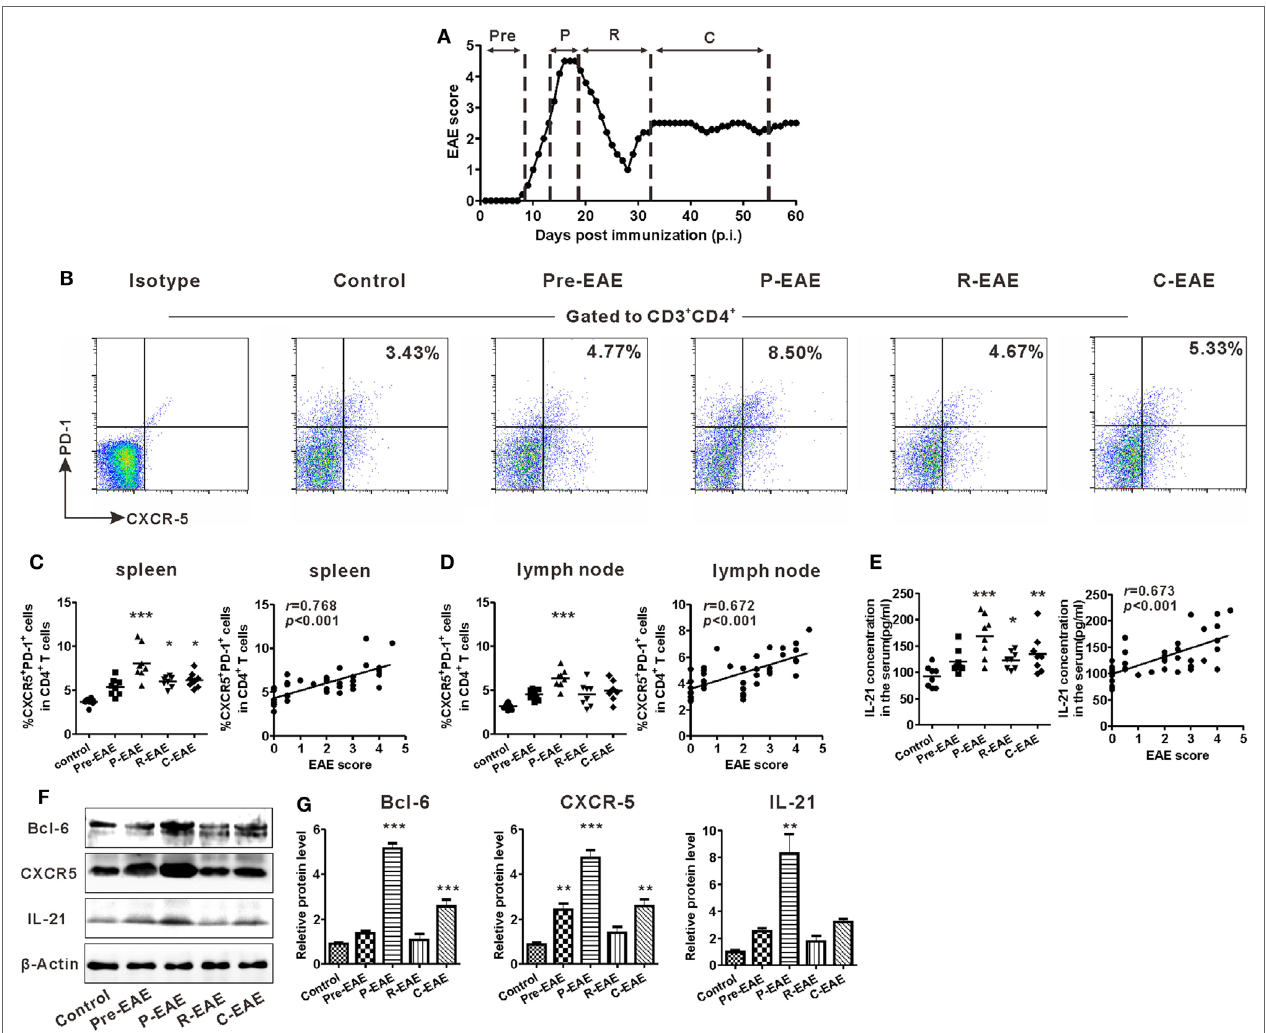
FigUre 2 | Kinetics of T follicular helper (Tfh)-like cell in the secondary lymphoid organs (SLOs) during the different phases of experimental autoimmune encephalomyelitis (EAE). (a) The clinical course of MOG 35–55 -induced EAE in C57BL/6J mice. Mean clinical score is shown ( n = 8). (B) Representative flow cytometry results of CD3 + CD4 + CXCR5 + PD-1 + Tfh-like cells in the spleens of EAE mice during different clinical phases. Gates were set on CD3 + CD4 + cells. Numbers in the upright corner illustrated the percentage of CXCR5 + PD-1 + cells in CD4 + T cells. Comparisons of the frequency of Tfh cells in spleens [ (c) left] and draining lymph nodes [ (D) left] at different phases of EAE mice ( n = 8/time point). The correlation analysis between the EAE score and the frequency of Tfh-like cells in spleens [ (c) right] or draining lymph nodes [ (D) right]. (e) The serum level of IL-21 at different phases of EAE mice (left, n = 8/time point) and its correlation with EAE score (right). (F) Representative blots band of Bcl-6, CXCR5, and IL-21 in splenocytes of EAE mice at different phases. (g) Statistical data of the relative protein level of Bcl-6, CXCR5, and IL-21 in splenocytes of EAE mice at different phases. Values are mean ± SEM. For (c–e) , each data point represents an individual subject and the horizontal lines represent the means ( n = 8). Results are representative of three independent experiments. Abbreviations: Pre, pre-clinical; P, peak; R, remission; C, chronic. * P < 0.05, ** P < 0.01, *** P < 0.001 vs.